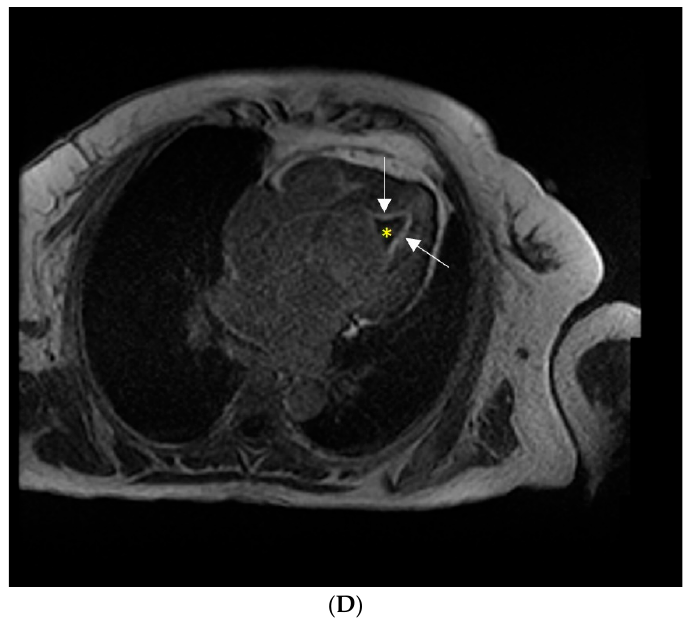
Figure 2. ( A ) Echo Parasternal long axis view showing obliteration of the left ventricular apex. ( B ) Echo Parasternal long axis view: normal-size left ventricle with normal systolic function, increased thickness of the posterior mitral leaflet and chordae, apical obliteration. ( C ) Cardiac MRI: 4 chamber view showing a normal-size left ventricle, with preserved ejection fraction and an apical mass engulfing the papillary muscles. ( D ) Cardiac MRI: inversion recovery images 10 min after contrast injection showing left ventricular apical thrombus (white arrows) and sub-endocardial enhancement (star).